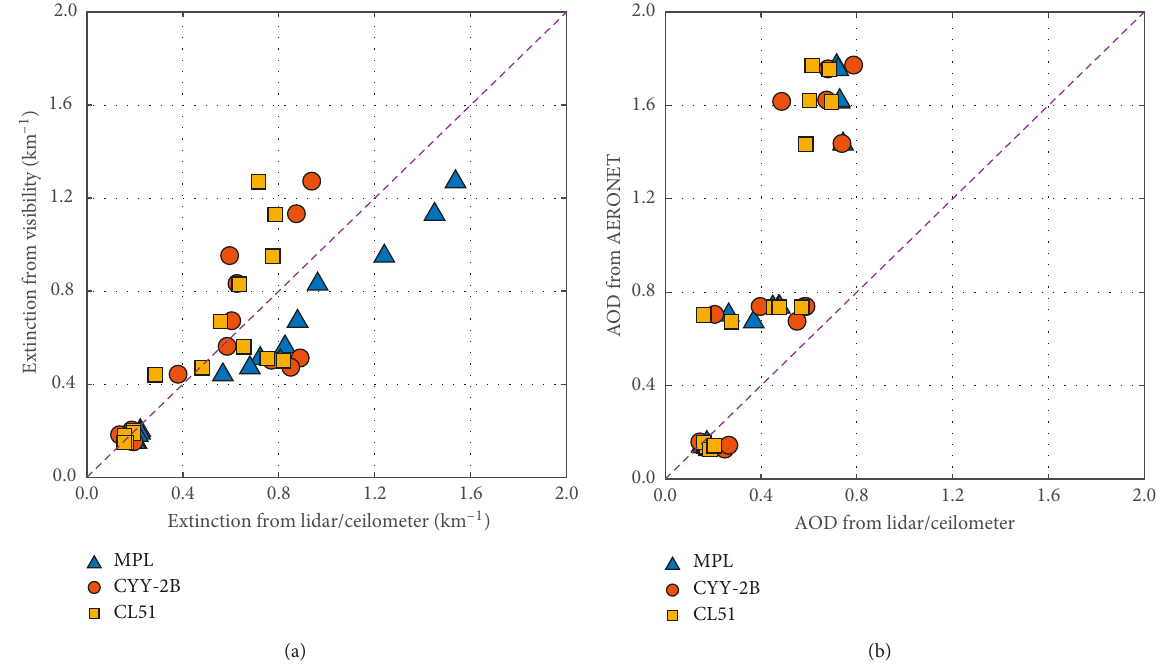
Figure 3: Comparison of extinction coefficient near surface and AOD derived from the ceilometers and the MPL